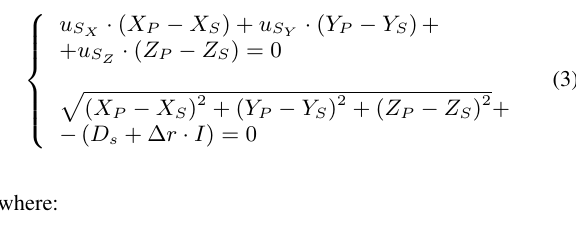
Figure 2: SAR acquisition system in zero Doppler geometry Therefore, the couple of equations in an ECEF (Earth Centered Earth Fixed) system (for example the WGS84)